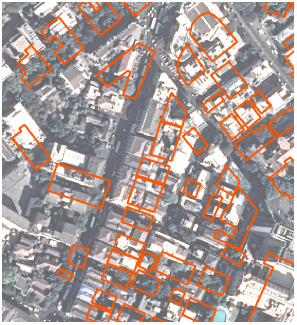
Figure 1. Projection of an OSM building layer on a PHR image of